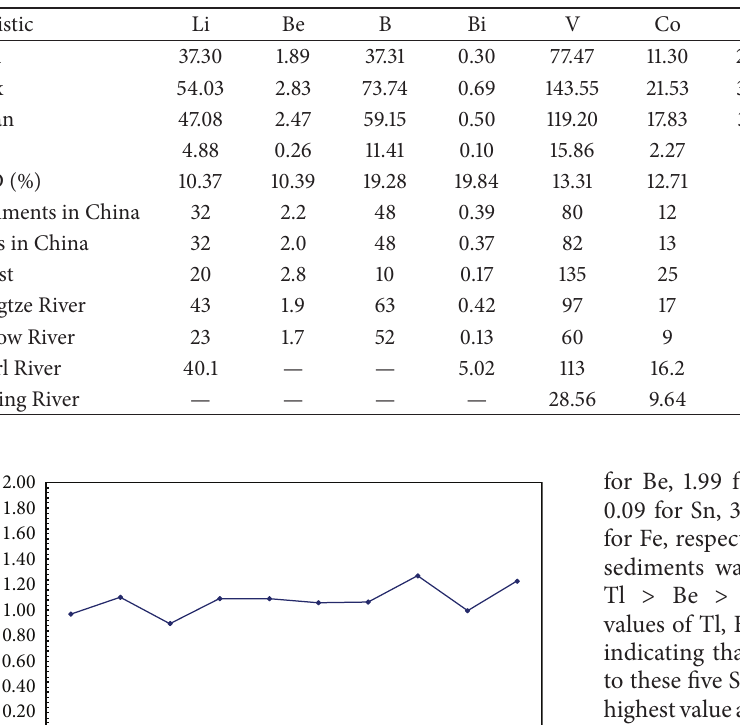
Table 3: Statistics results of SMTEs concentrations in sediments of TGR (mg ⋅ kg − 1 ).